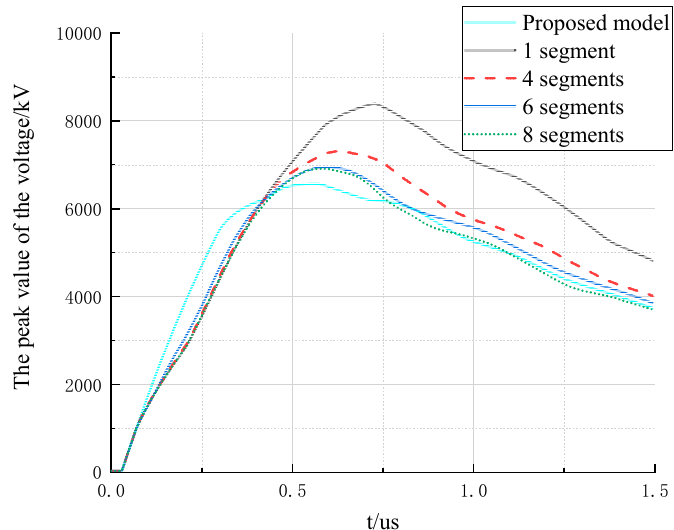
Figure 12. The peak value of the voltage with the non-uniform transmission line model and with the multi-segment multi-surge model.